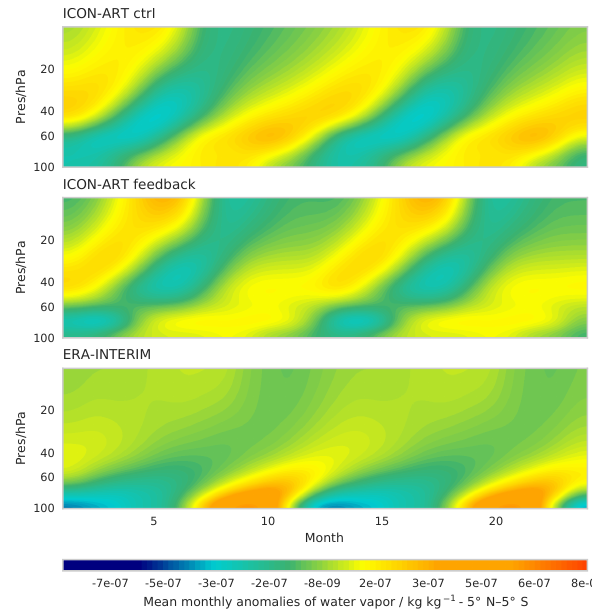
Figure 13. Tropical (5 ◦ N–5 ◦ S) water vapour anomalies as monthly mean deviations (plotted twice) from the annual mean, averaged from 1990 to 2009, as a function of months and